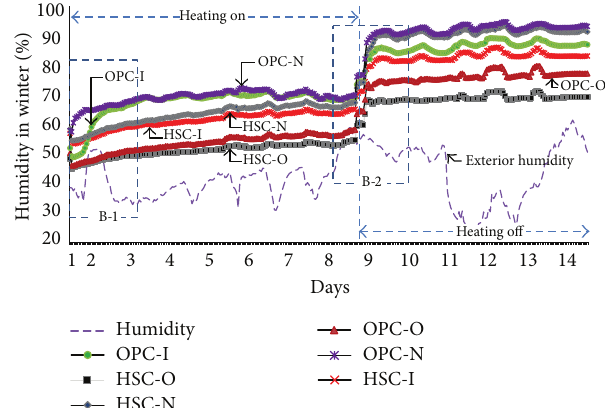
Figure 6: Results of humidity measurements of the interior of the specimens in